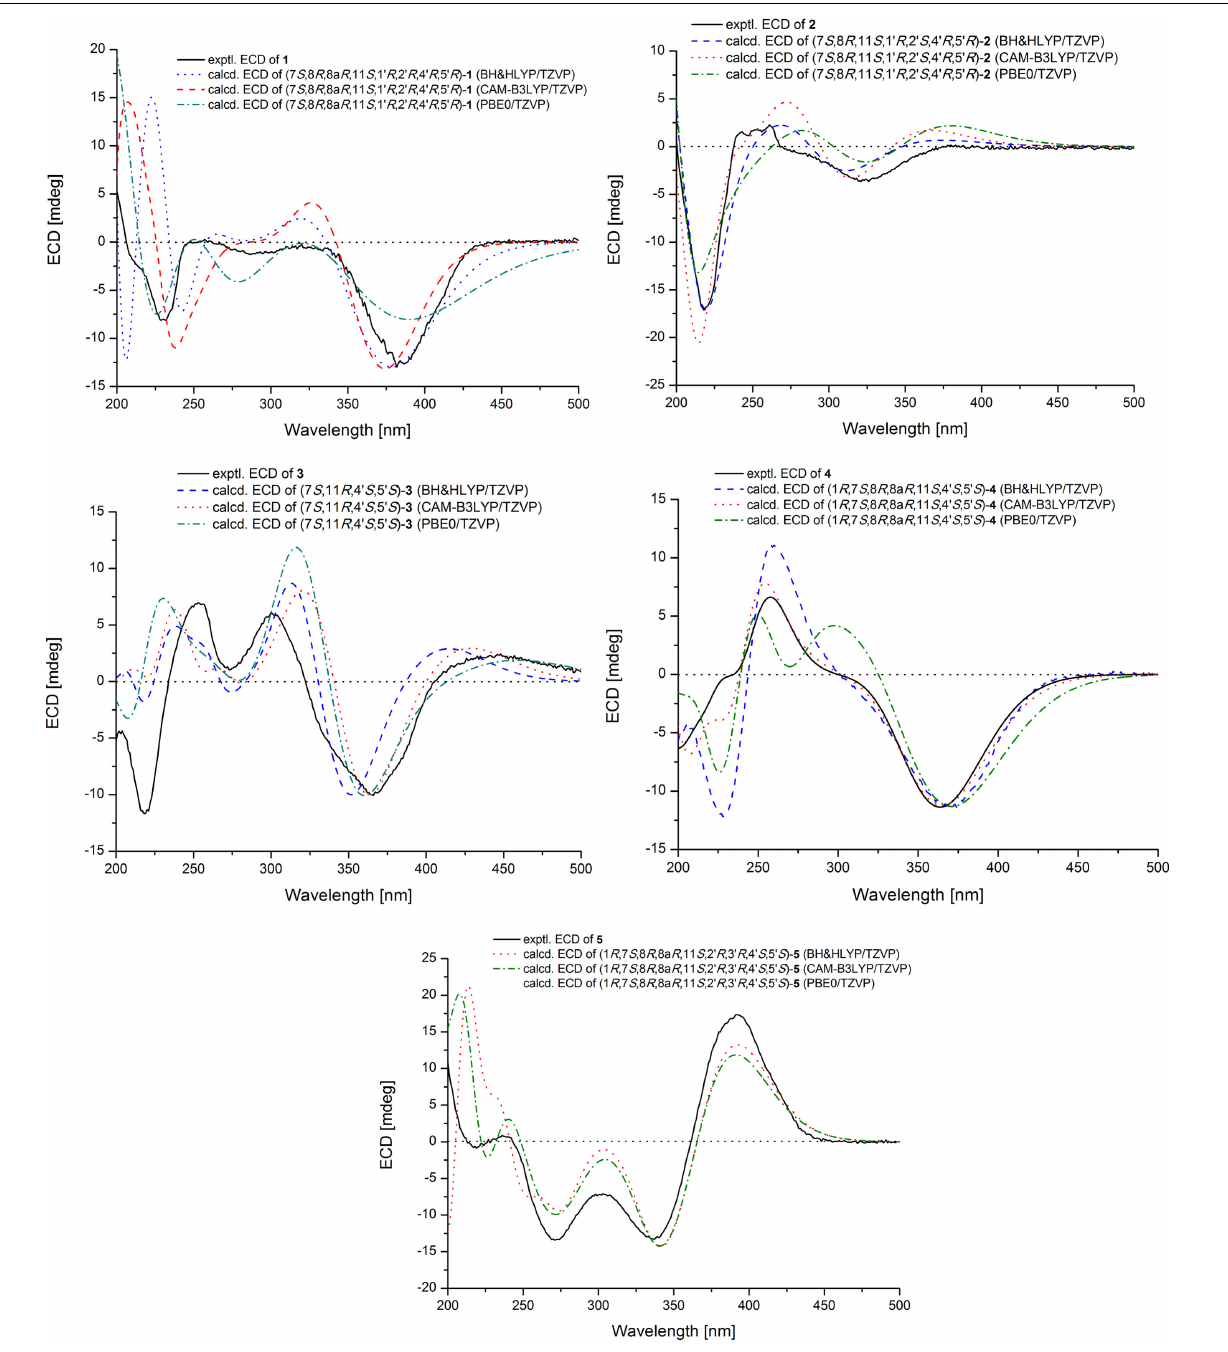
as NOESY ( Figure 3 ) correlations from CH 3 O-8 to CH 3 - 7 and H-1, indicated their same relative configuration. The optical rotation value (–107) and experimental ECD curve were very similar to those of 9 (–37), suggesting their same (1 R ,7 S ,8 R ,8a R ,11 S ,4 (cid:48) S ,5 (cid:48) S ) absolute configuration. The calculated ECD spectrum for the (1 R ,7 S ,8 R ,8a R ,11 S ,4 (cid:48) S ,5 (cid:48) S )-4 matched